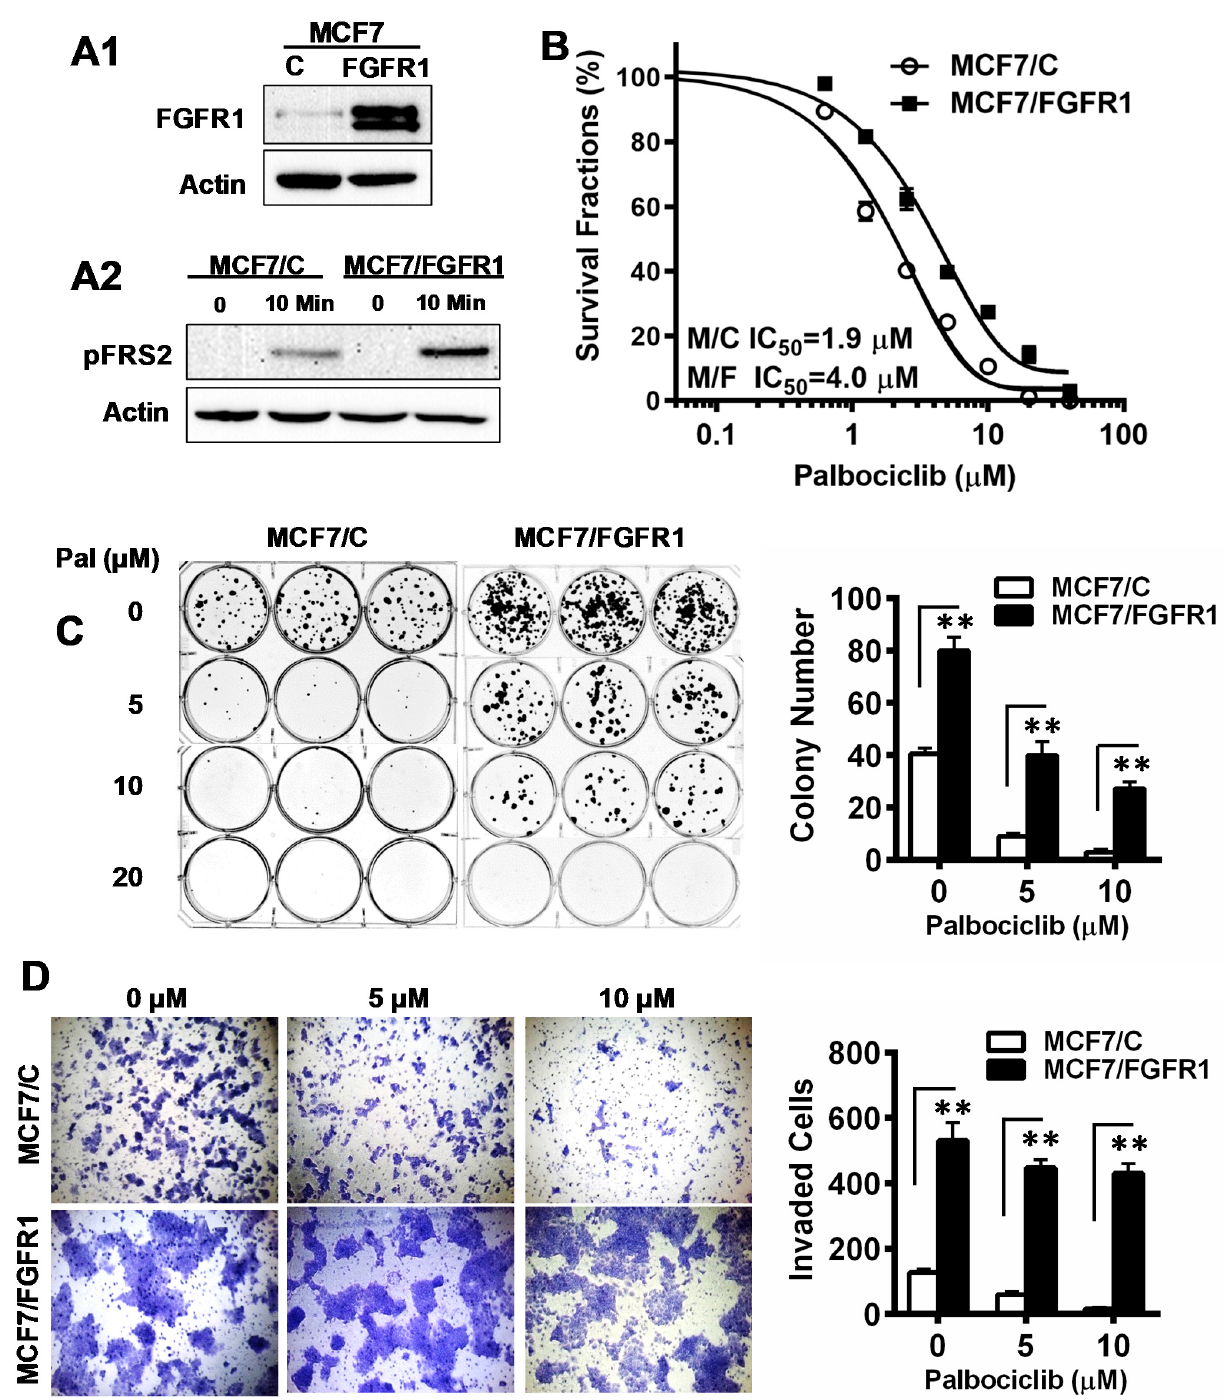
Figure 1. FGFR1 overexpression in MCF-7 cells induces resistance to palbociclib-mediated inhibition of proliferation and invasion. ( A1 ) FGFR1 levels in MCF-7/C and MCF-7/FGFR1 cells. ( A2 ) FGFR1-induced activation of FRS2 in MCF-7/C and MCF-7/FGFR1 cells. The cells were starved with serum-free media for 48 h and then treated with bFGF (100 ng/mL) for 10 min, followed by Western blot analysis. ( B ) MCF-7/C and MCF-7/FGFR1 cells were treated with palbociclib (0–40 μ M) for 5 days, followed by an XTT assay. IC 50 values were analyzed with Prism 7. ( C ) Clonogenic assays of drug-treated MCF-7/C and MCF-7/FGFR1 cells. The cells were treated with palbociclib (0, 5, 10 µ M) for 2 weeks. The colonies were